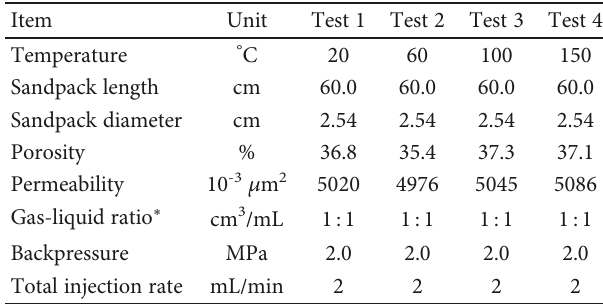
Figure 2: Flow chart of the combined experimental system of the sandpack and micromodel. Table 1: Experimental parameters and